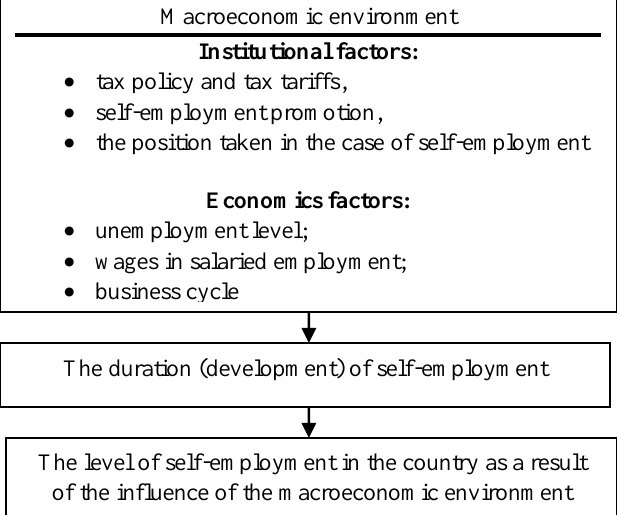
Fig. 1. The factors that have impact on self-employment development (source: compiled by the author).